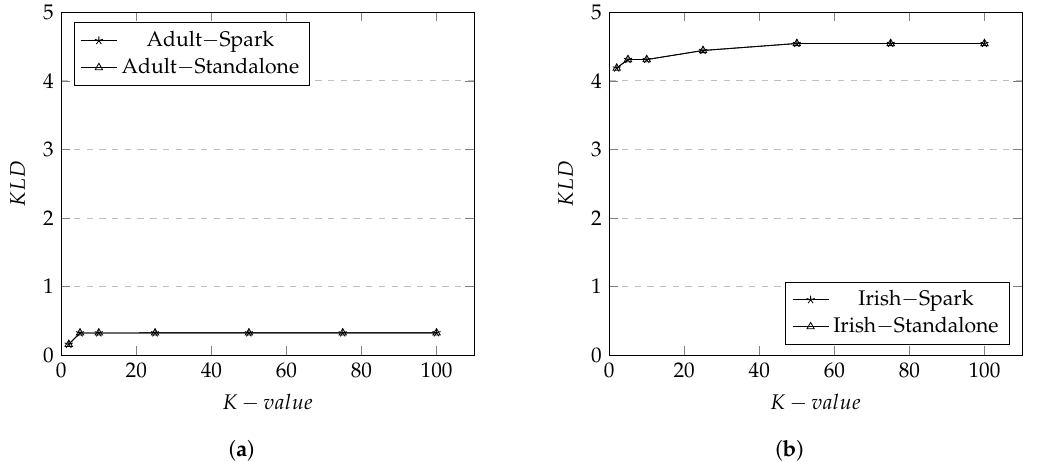
Figure 6. Divergence for Adult and Irish datasets on both Spark and Standalone. ( a ) KL -Divergence in Adult Dataset; ( b ) KL-Divergence in Irish